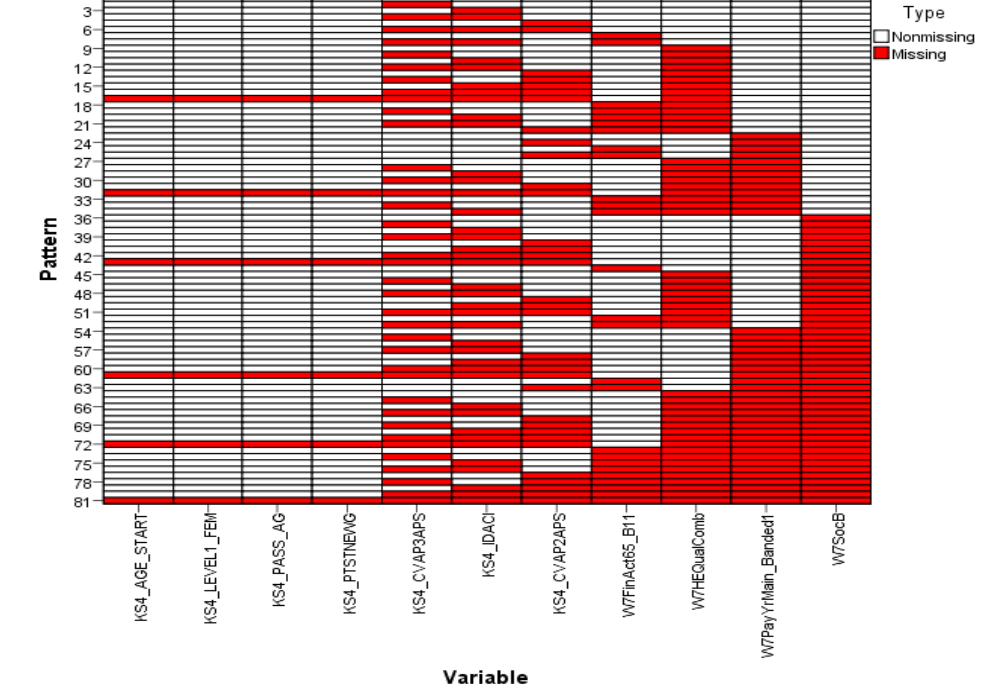
Figure 1. Missing value patterns.